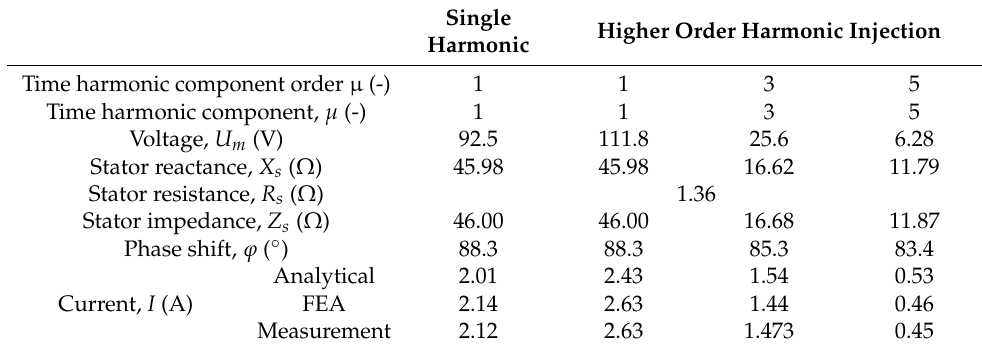
Table 5. Harmonic component currents: comparison among the results of analytical calculation, finite element method analysis (FEA), and measurement.